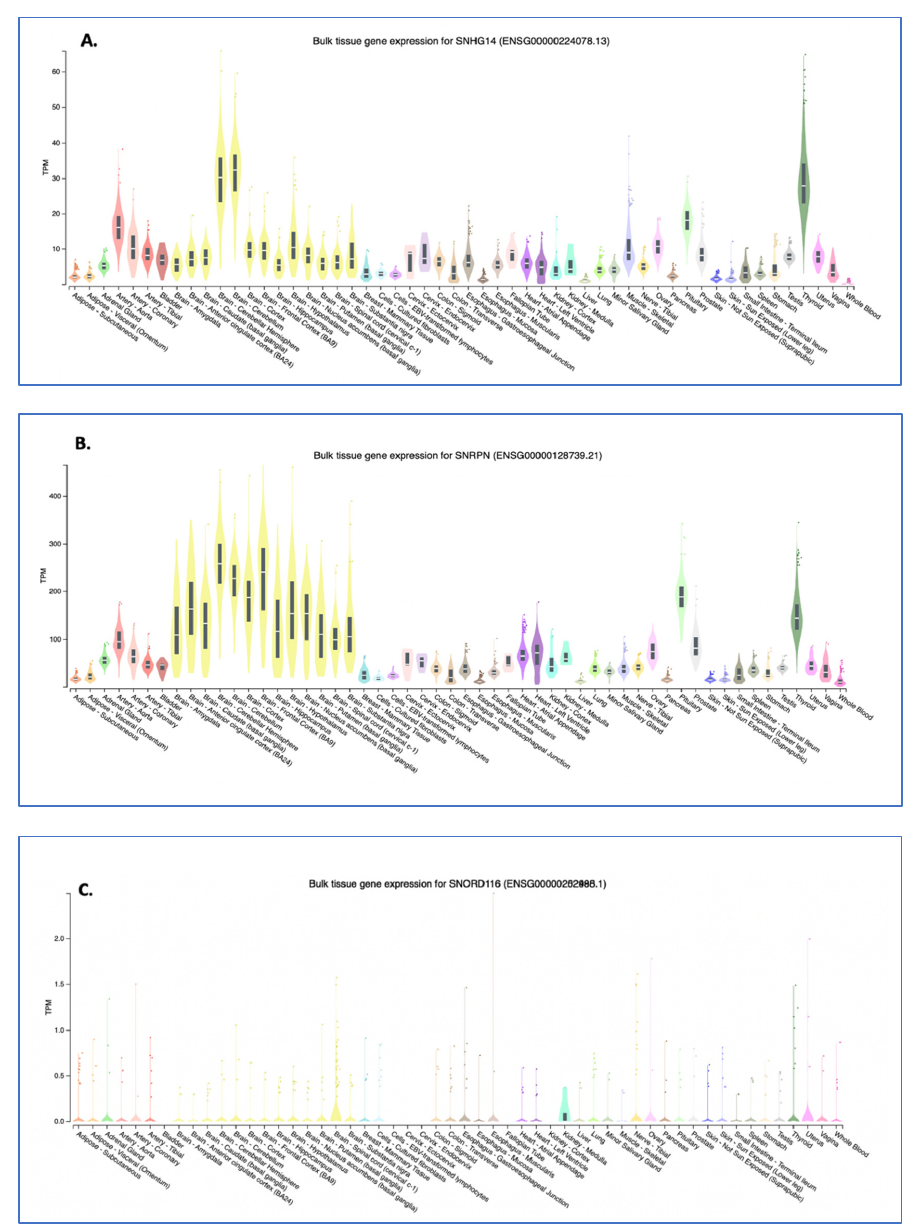
Figure 4. GTEX tissue expression analysis for SNHG14 transcripts. The GTEX expression portal was used to examine the tissue expression pattern for the SNHG14 host gene ( A ) and two of the genes encoded in the SNHG14 transcript, SNRPN transcripts ( B ), and SNORD116 transcripts ( C ). GTEx Analysis Release V8 (dbGaP Accession phs000424.v8. p2), using 54 tissues and 948